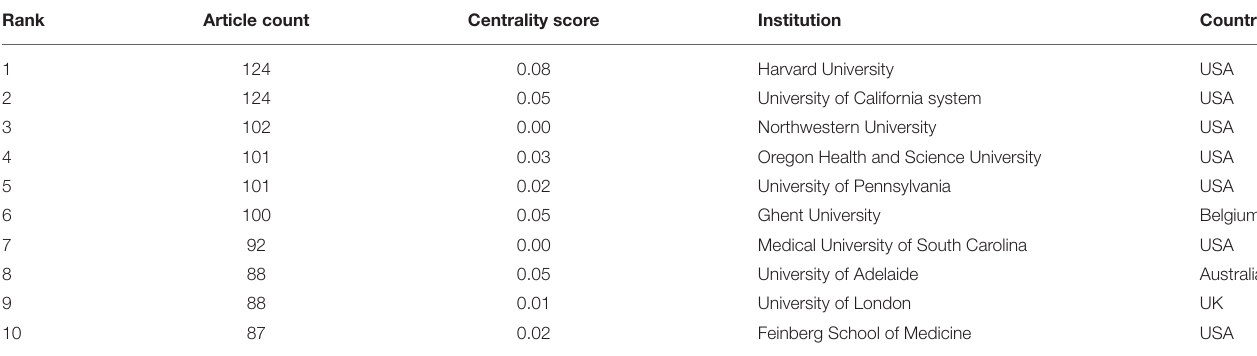
TABLE 2 | Ranking of top-10 institutions that have collaborated the most on CRS-treatment research from 2001 to 2020.